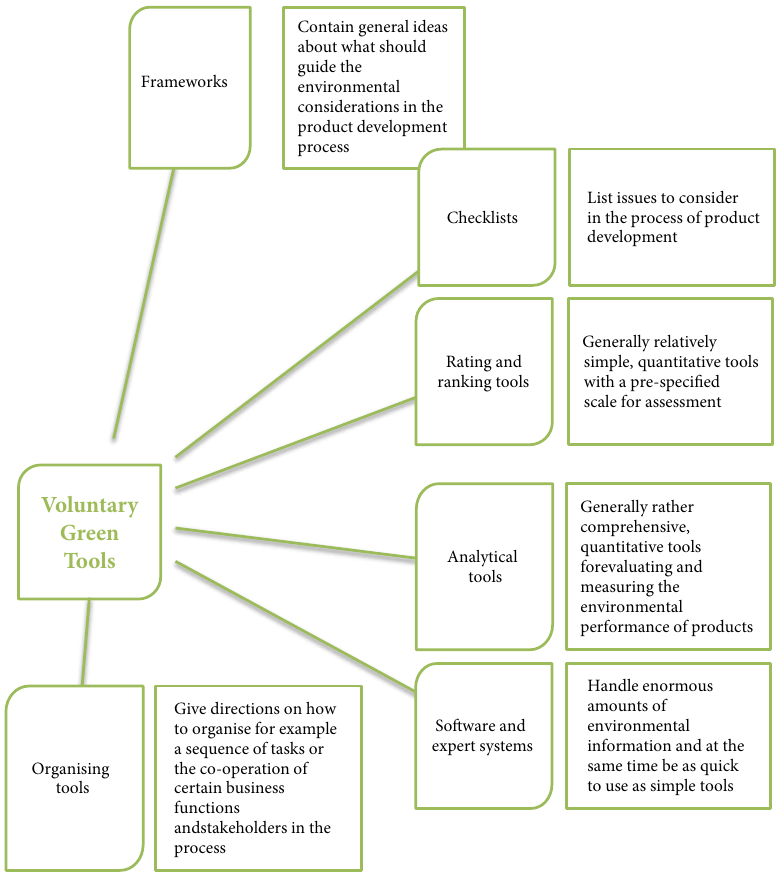
Figure 1. Classification of green building rating